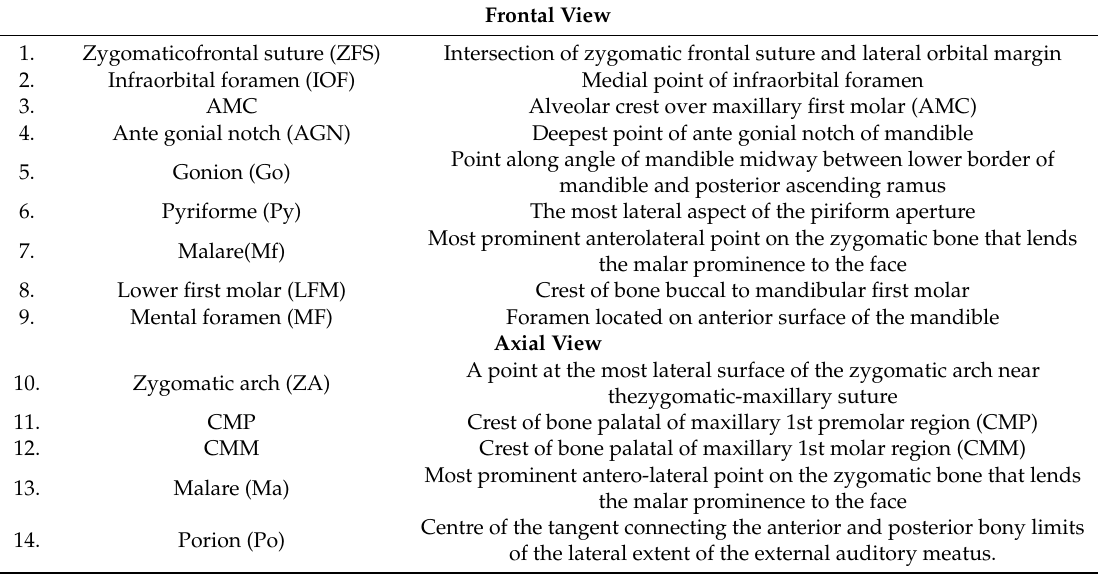
Table 2. Landmark definitions for asymmetry